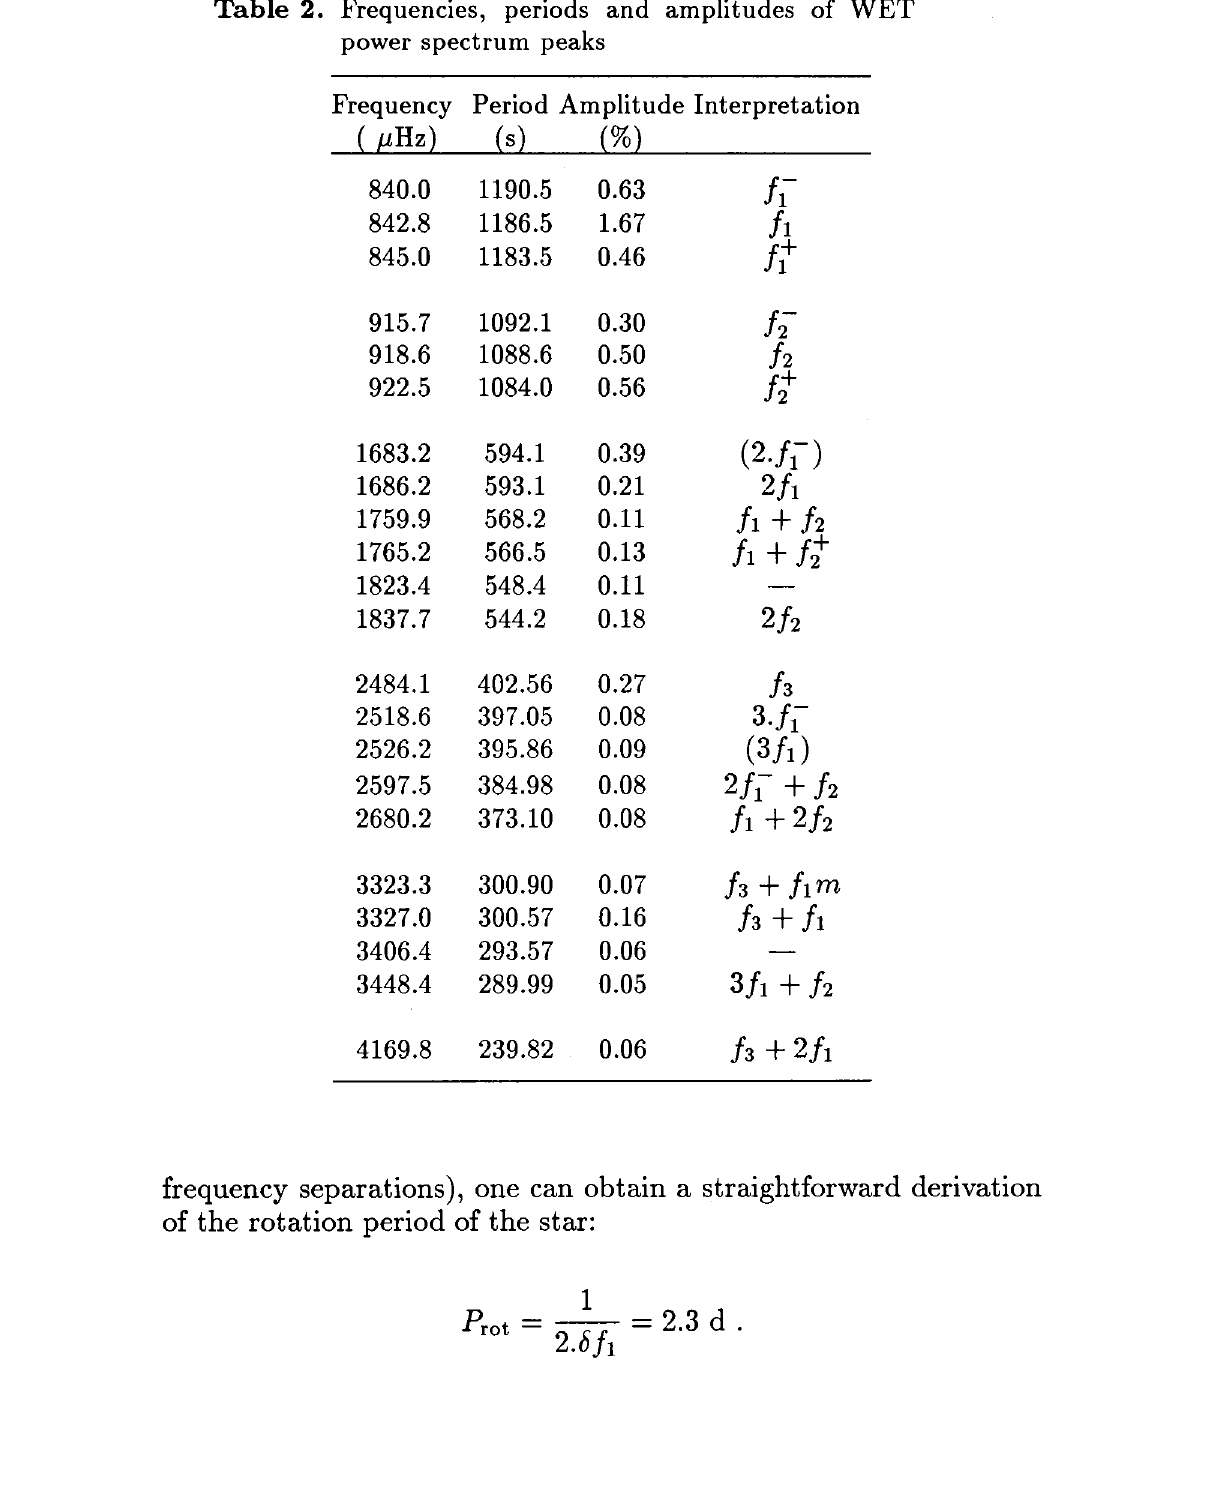
Table 2. Frequencies, periods and amplitudes of WET power spectrum